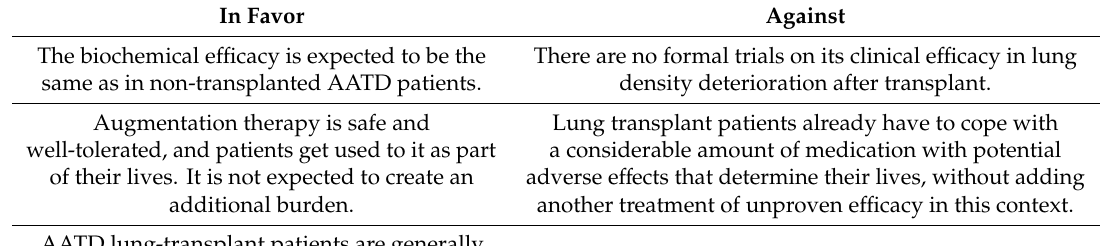
Table 3. Arguments for and against maintaining augmentation therapy after lung transplant. In Favor